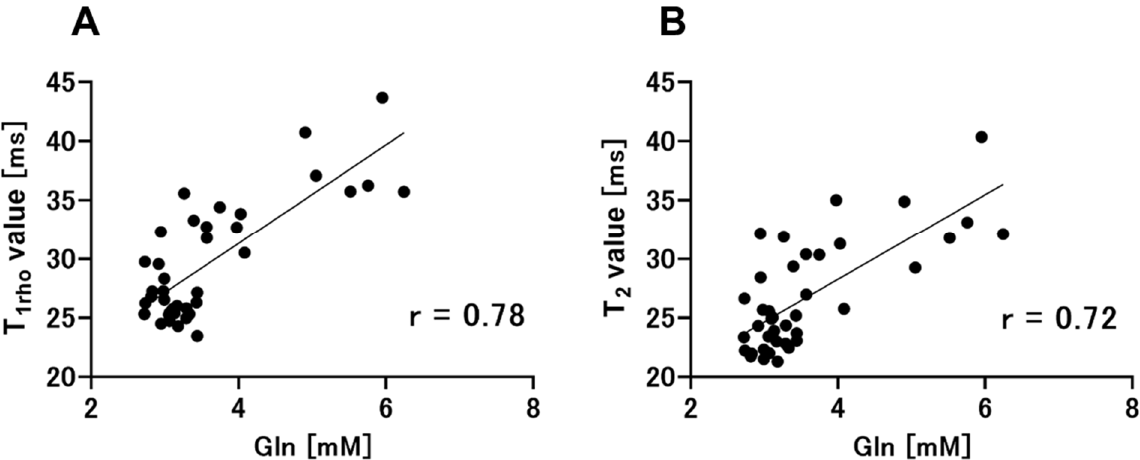
Figure 6. Pearson’s correlation coefficients and correlation analysis were performed to compare the two groups (T 1ρ relaxation times vs. brain Gln levels, T 2 relaxation times vs. brain Gln levels). ( A ) The analysis of T 1ρ relaxation times and brain Gln levels also indicates a positive correlation between these parameters (r = 0.78, p < 0.01). ( B ) T 2 relaxation times are positively correlated with brain Gln levels (r = 0.72, p < 0.01). Gln, glutamine.